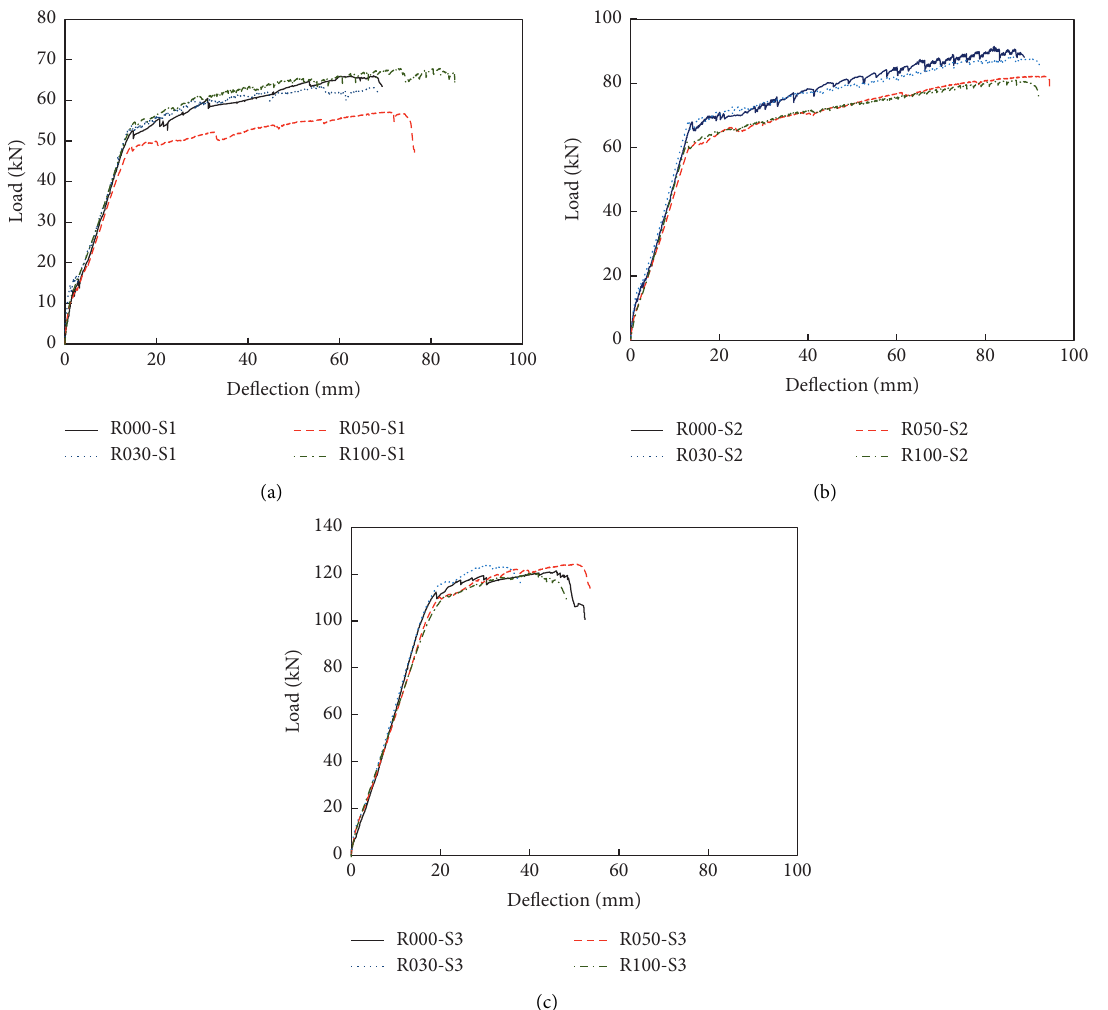
Figure 9: Effect of the RCA content on the load-deflection curves. (a) S1 series beams (rebar ratio of 0.50%). (b) S2 series beams (rebar ratio of 0.79%). (c) S3 series beams (rebar ratio of